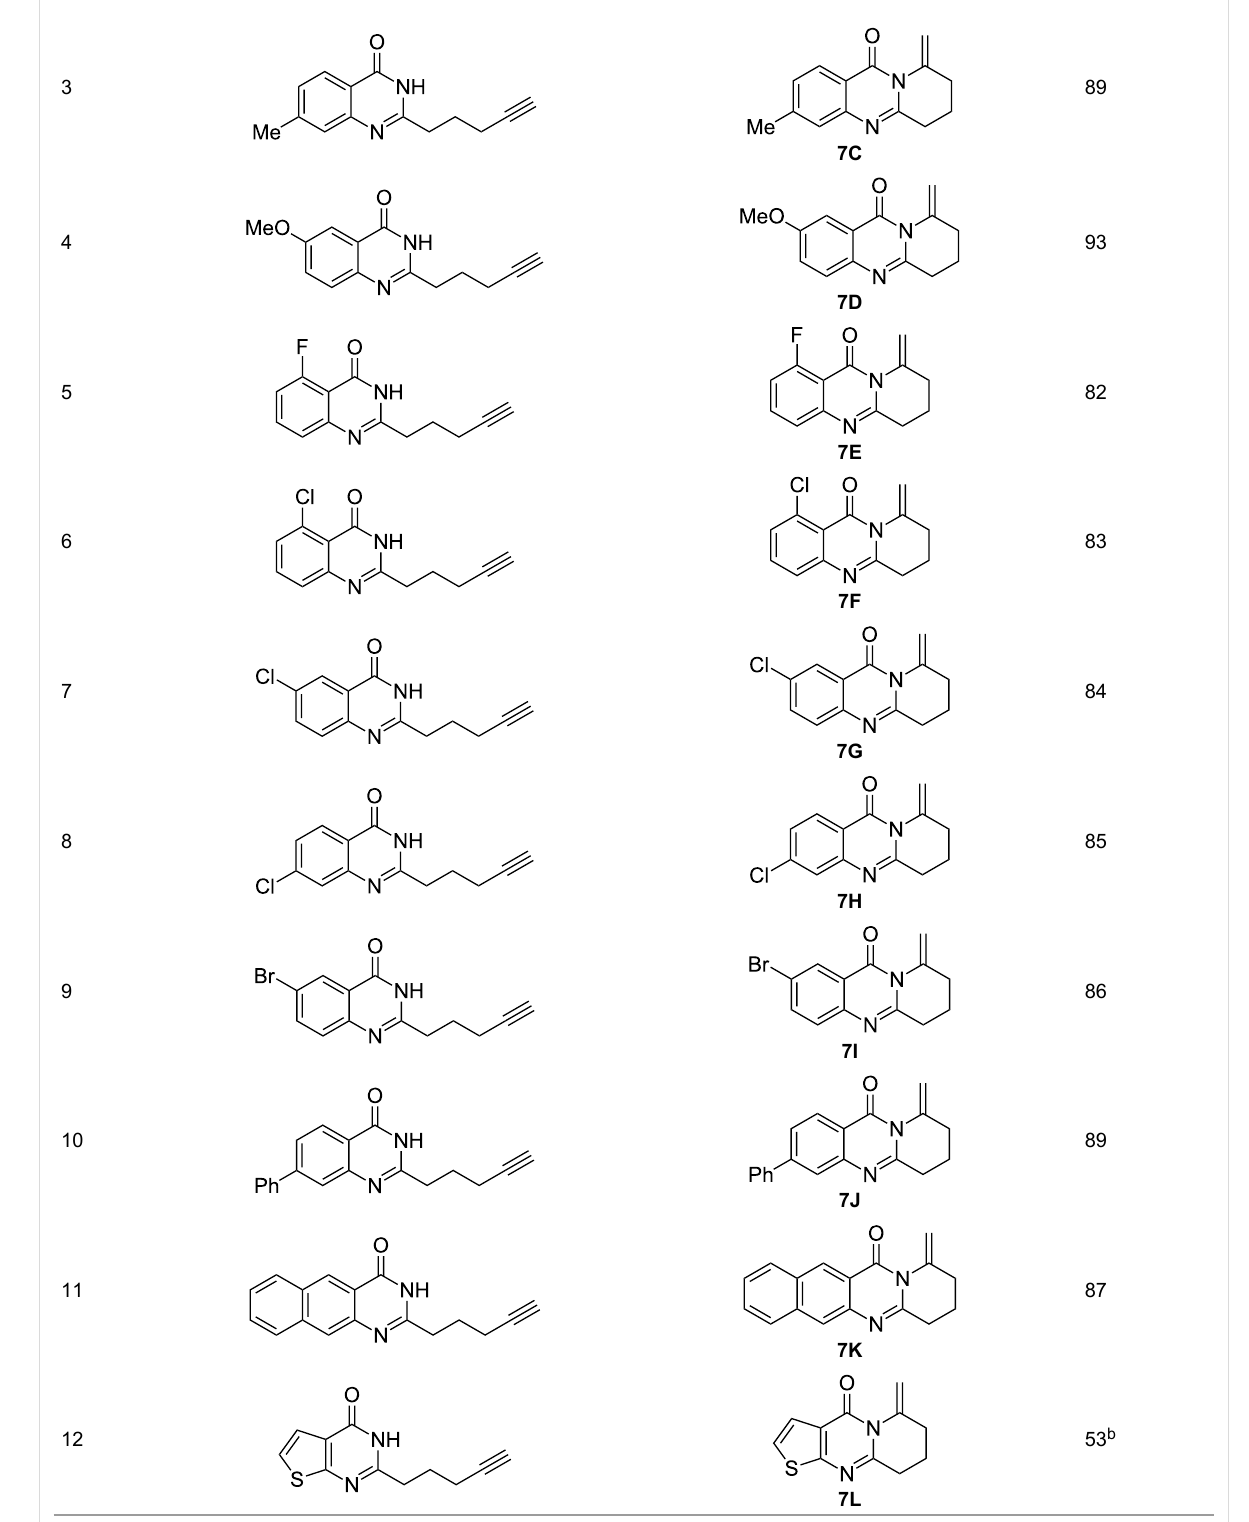
Table 2: Silver-mediated synthesis of target compounds 7A–L . a (continued)